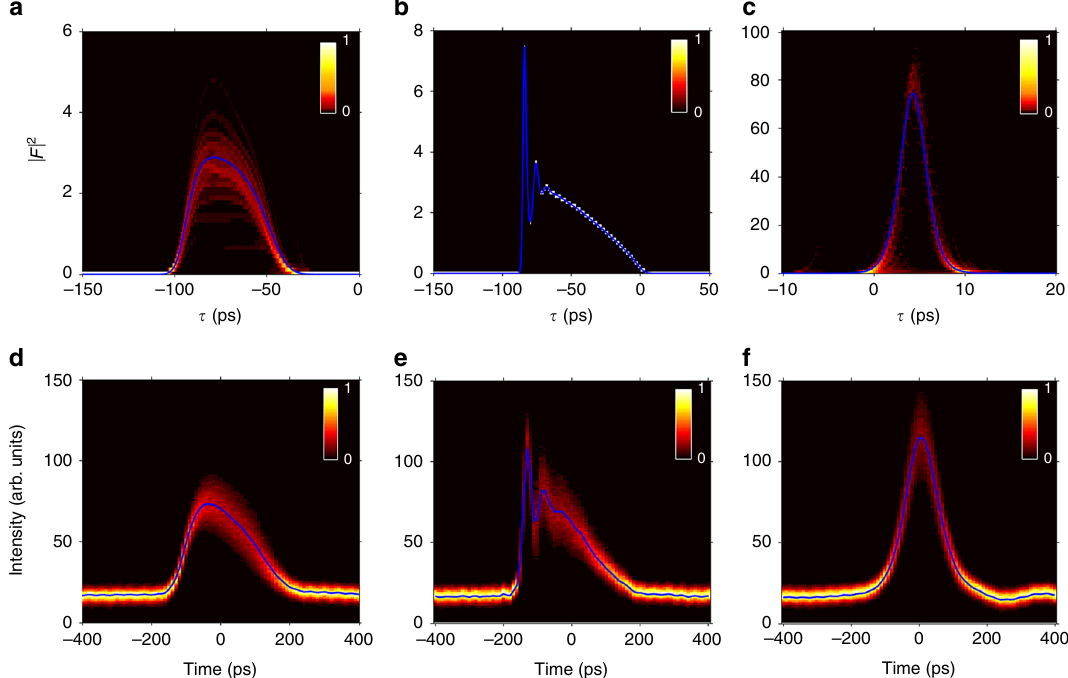
Fig. 4 Typical shapes of pulses. The three paradigmatic pulse shapes predicted theoretically ( a ), ( b ) and ( c ) are compared with their experimentally observed counterparts: ( d ), ( e ) and ( f ) (the experimental plots show the pulse intensity statistics, light and dark colors correspond to more and less frequent events respectively, while the blue lines show the average pulse intensity). The vertical axis in experimental plots refer to the photocurrent measured by the detector. Same parameters as in Fig. 3, with Δ = − 101.73, 2.63 and 148.15 kHz in ( a ), ( b ), and ( c ) respectively.